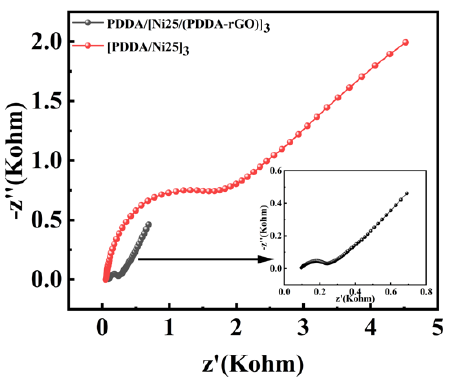
Figure 11. EIS spectra of two films [PDDA/Ni25] 6 and PDDA/[Ni25/(PDDA − rGO)] 6 .